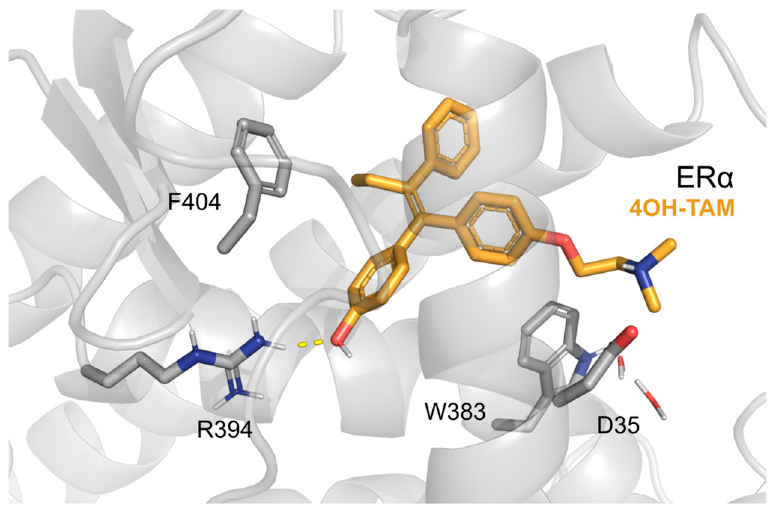
Figure 3. Crystal structure of 4-hydroxytamoxifen bound to ER α (PDB 3ERT). The dimethylamino group is solvent exposed allowing for attaching the linker without substantial disruption of binding.